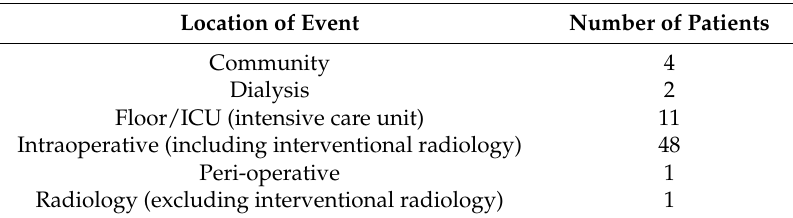
Table 1. Location of events resulting in air